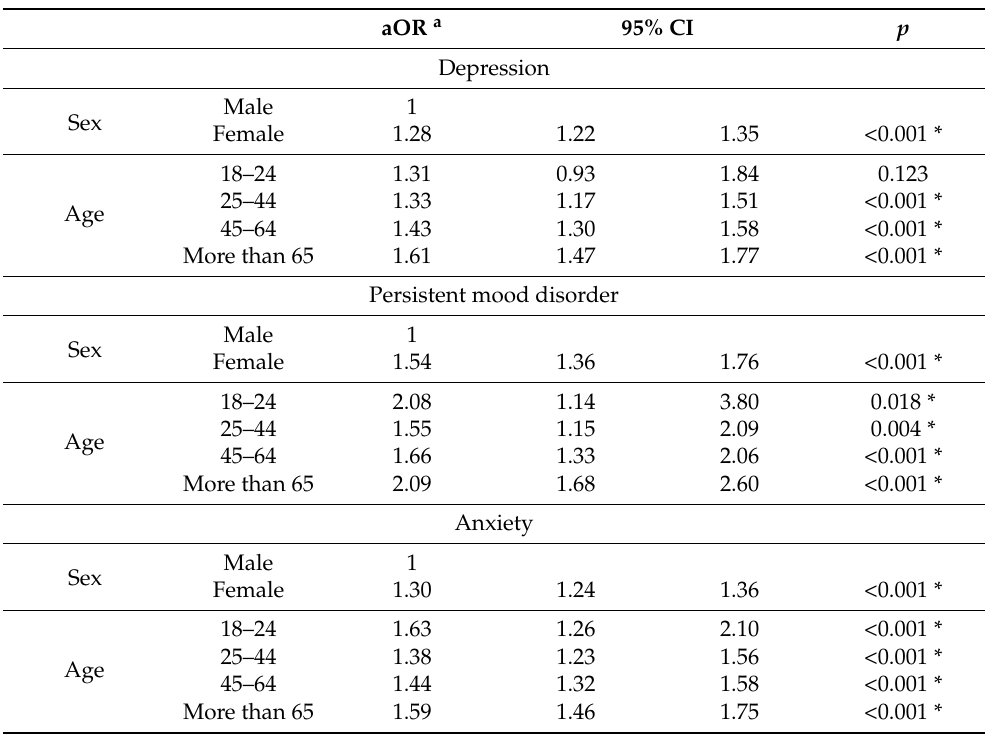
Table 3. Logistic regression models with grouped diagnostic